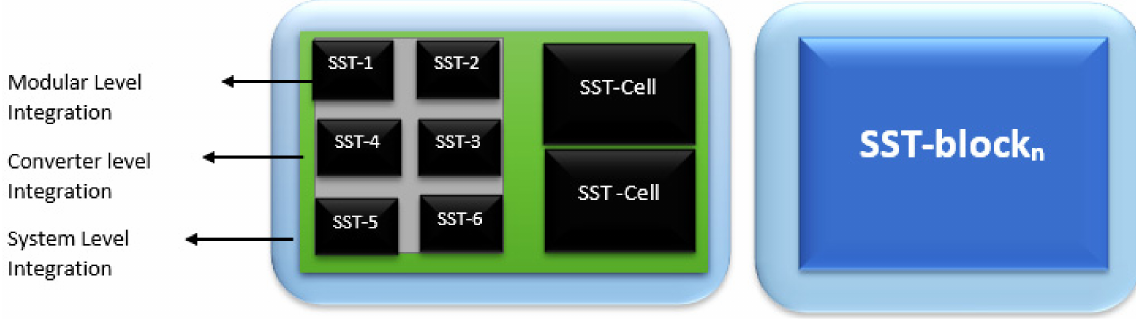
Figure 2. SST block with different modularity